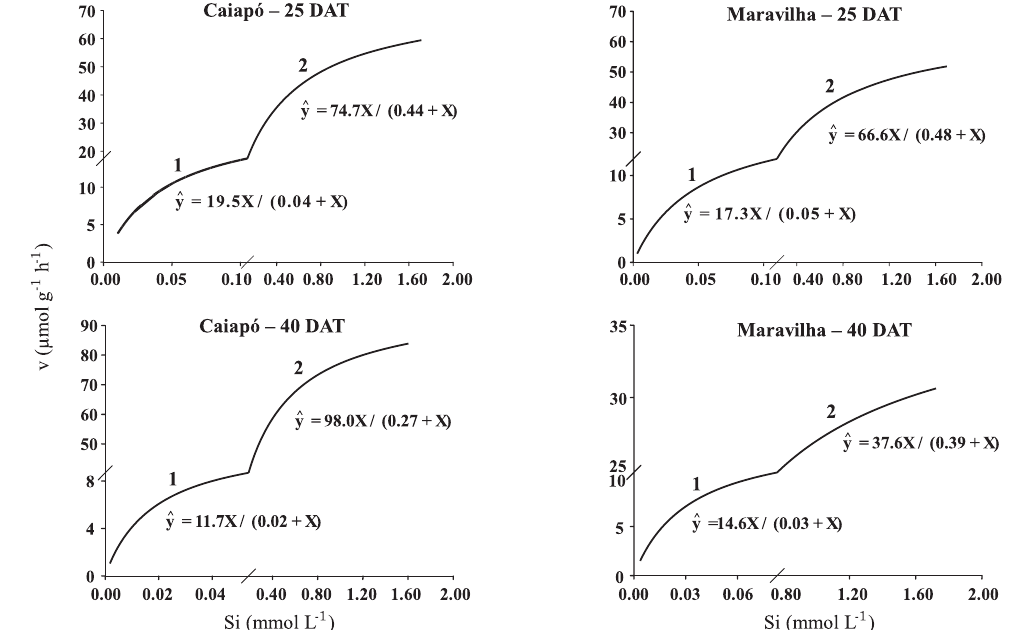
figure 2. silicon uptake velocity and participation of high - (1) and low-affinity uptake mechanisms (2) in rice cultivar roots 25 and 40 days after transplanting (Dat) as a function of si concentration in the nutrient